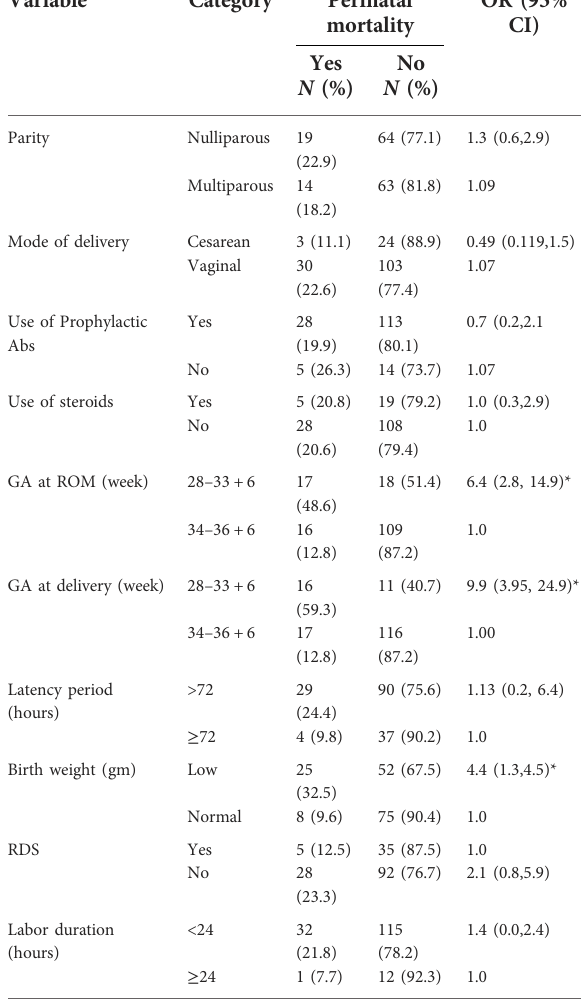
TABLE 6 Factors determining perinatal mortality among pregnant women with preterm premature rupture of membrane.